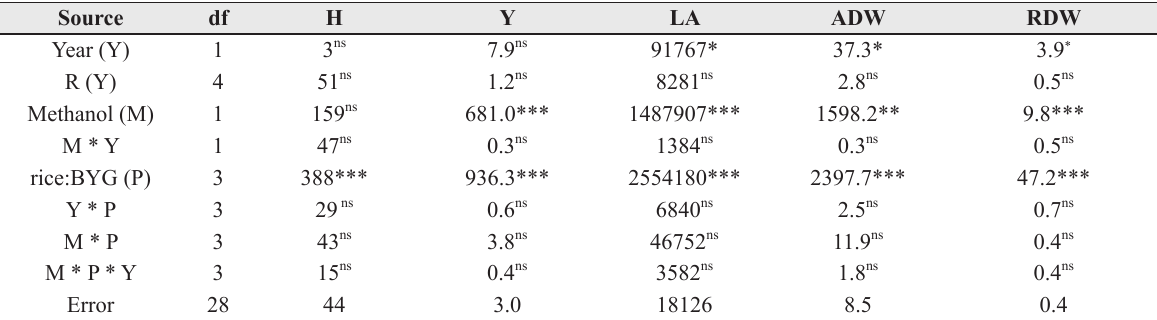
Mean squares for the combined analysis of variance for rice plant height (H), grain yield (Y), leaf area (LA), aboveground dry weight (ADW), root dry weight (RDW) as affected by methanol foliar application (M) and rice:BYG mixture proportion (P).